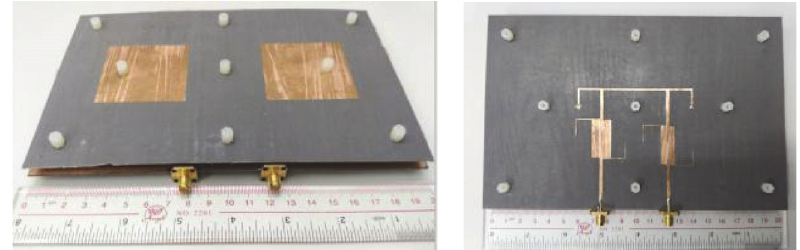
Figure 8: Prototype of the fabricated antenna array.